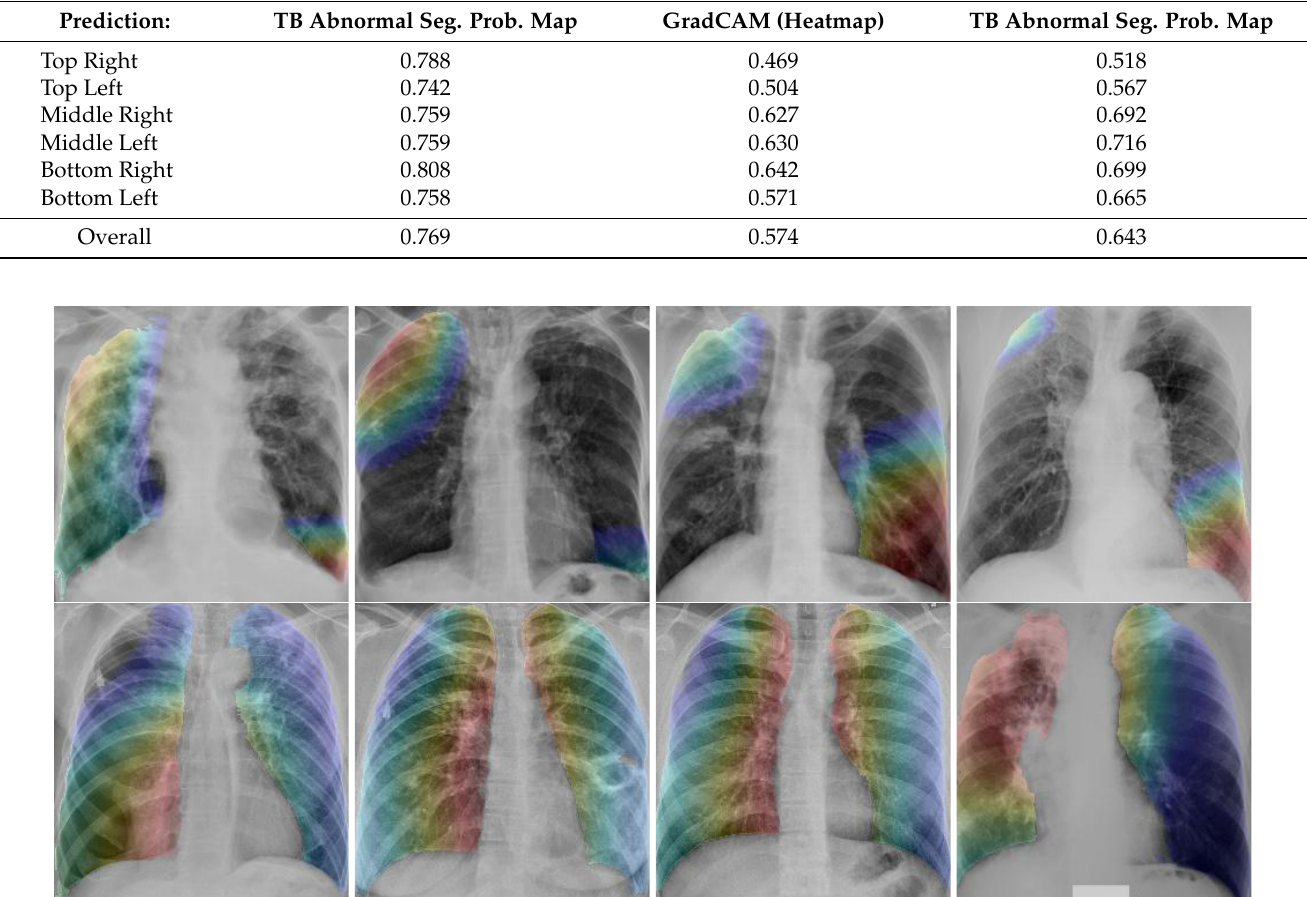
Figure 13. GradCAM visualizations on X-ray images. Top row shows examples of drug-sensitive TB and bottom row shows examples of drug-resistant